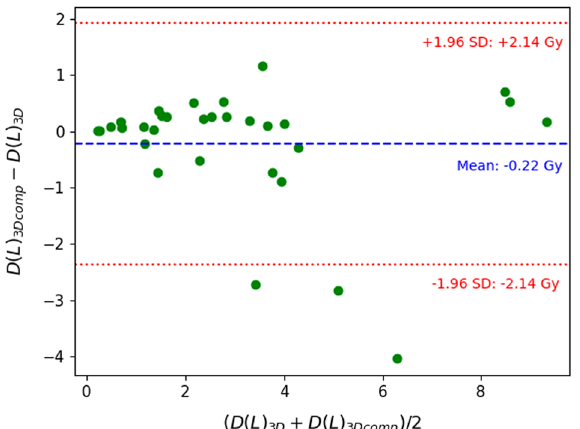
Fig. 3 Bland–Altman plot of the lung dose (Gy) between 3D and 3Dcomp reconstructions for each patient. D(L) 3D and D(L) 3Dcomp correspond to the lung dose estimated from the 3D and 3Dcomp reconstructions, respectively